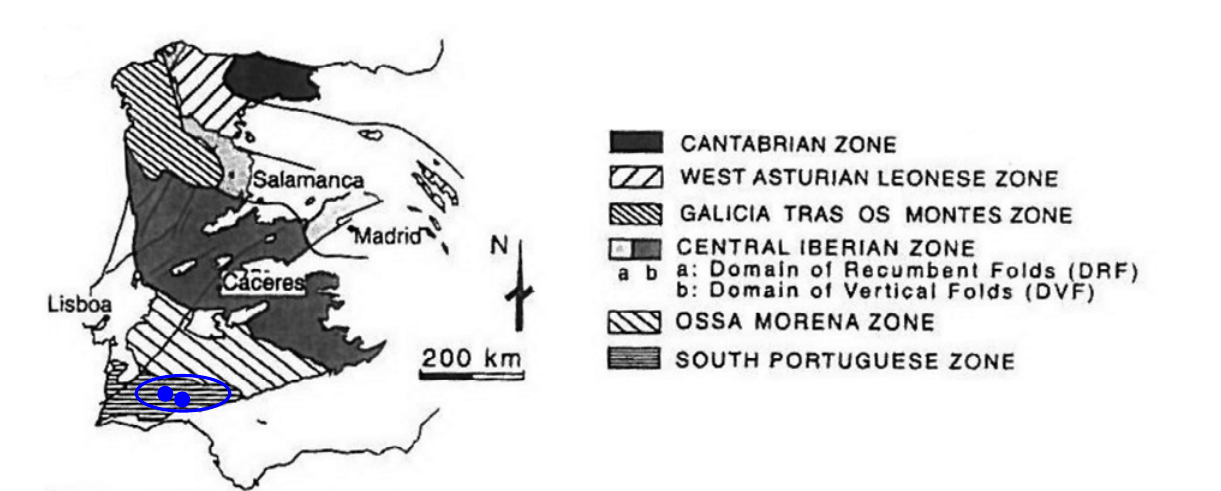
Figure 1. Location of the study area in the Iberian Hesperian Massif (Spain and